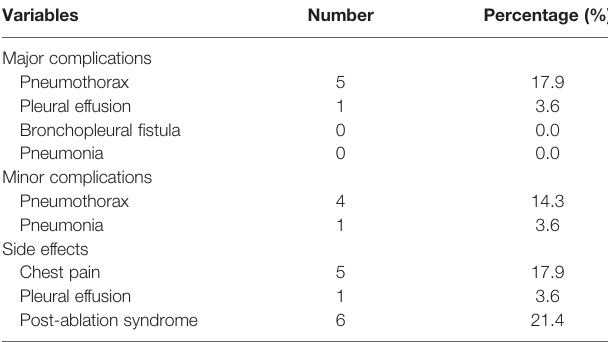
TABLE 2 | Details of MWA-related complications in group A.